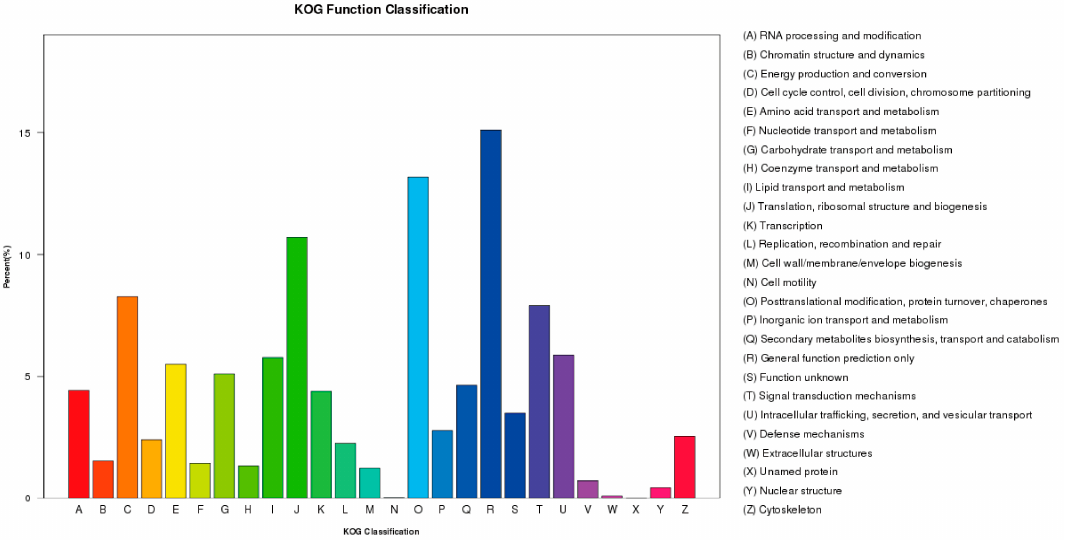
Figure 4. euKaryotic Ortholog Groups (KOG) functional categories for F. proliferatum .